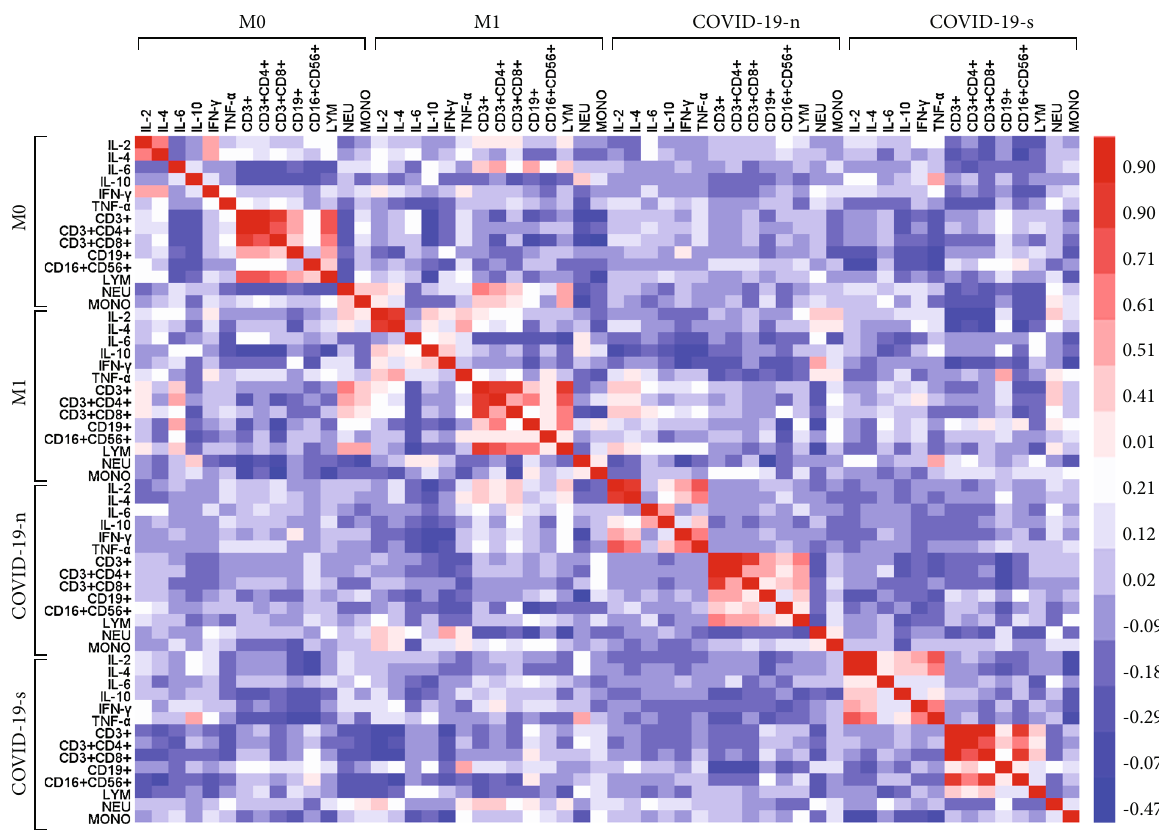
Figure 3: Heat maps for correlation coe ffi cients of patients with COVID-19 or cancer. M0: nonmetastatic cancer patients; M1: metastatic cancer patients; COVID-19-n nonsevere COVID-19 patients; COVID-19-s: severe COVID-19